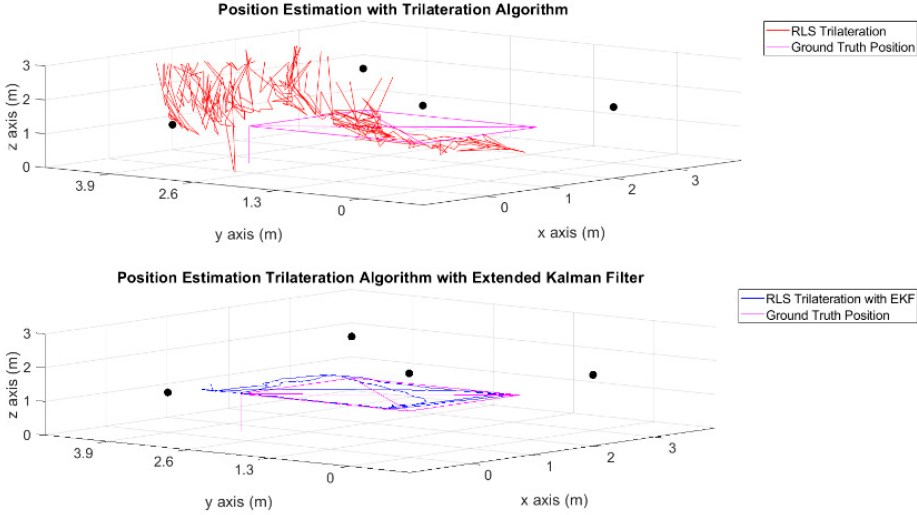
Figure 4. Position Estimation in Path 2 Trilateration Algorithm with and without EKF.